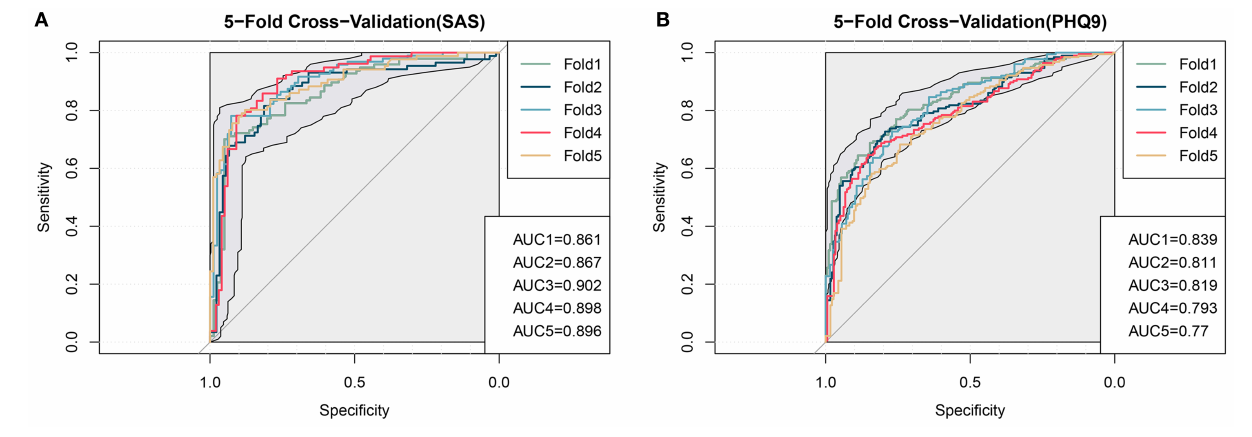
FIGURE 2 | Evaluation of the logistic model by 5-fold cross-validation. (A) anxiety; (B) depression. AUC, area under the